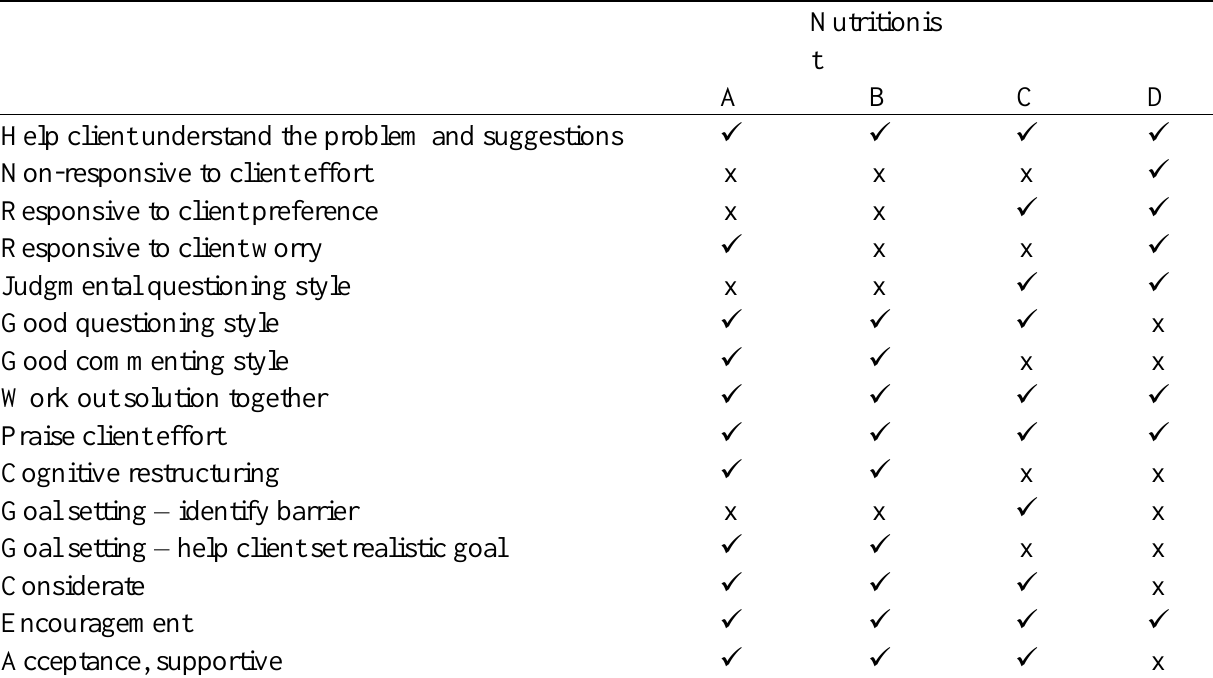
Table 5. Observational evaluation of nutritionists using 24 client